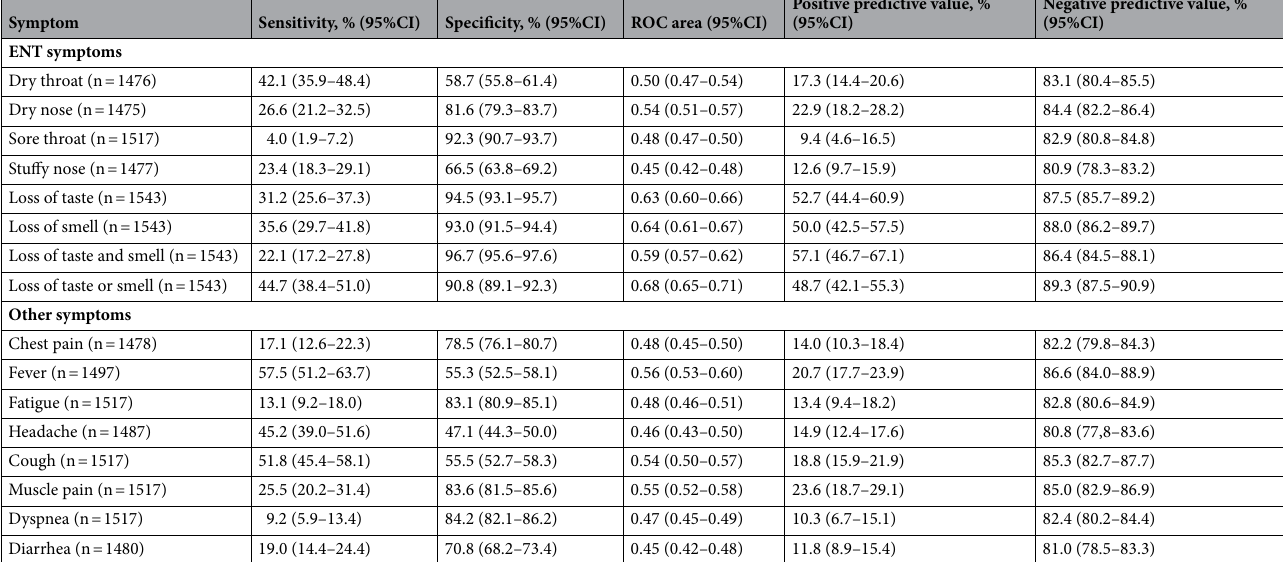
Table 4. Diagnostic performance of commonly reported